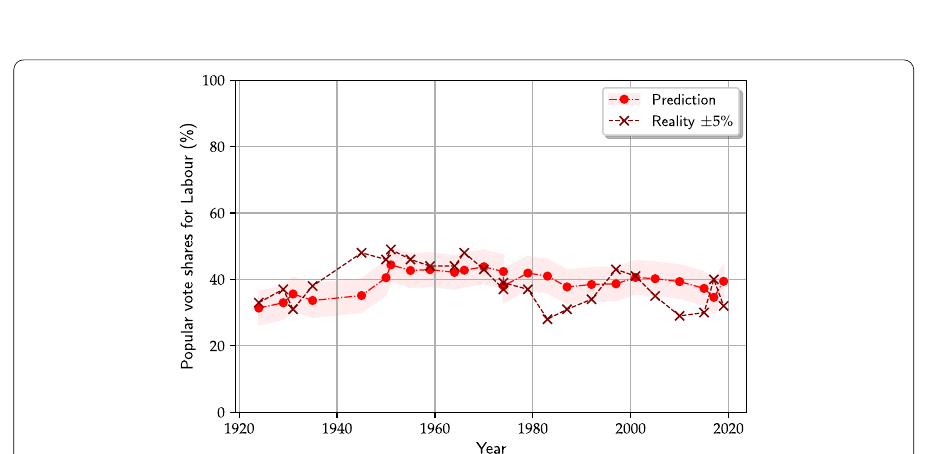
Fig. 2 Percentage of popular votes for Labour in the UK, prediction and reality. The shaded area covers a ± 5% deviation away from the